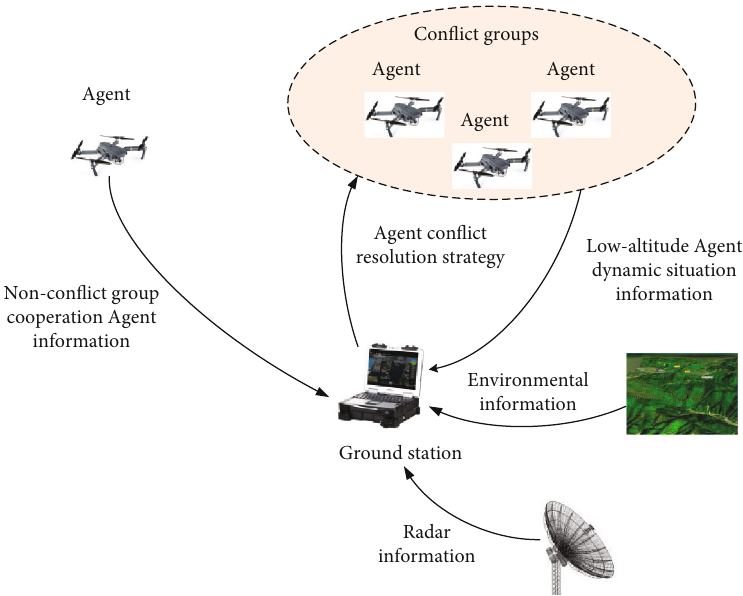
Figure 1: Low-altitude UAV con fl ict resolution mechanism